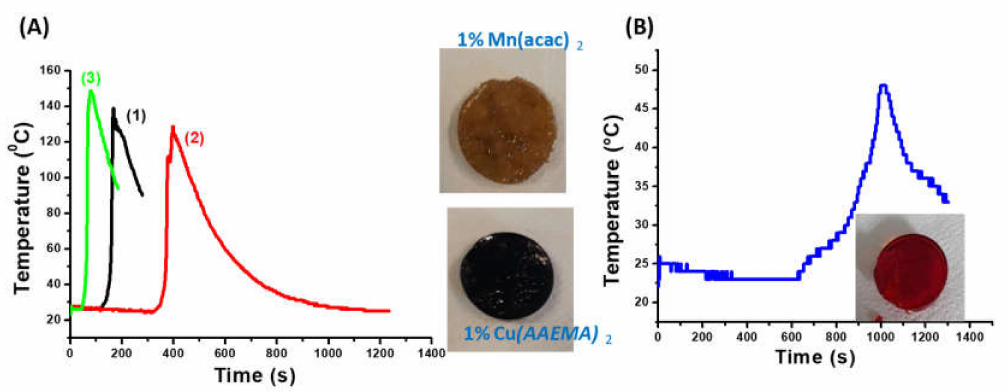
Figure 2. Optical pyrometric measurements (temperature vs. time after mixing; 4 mm thick sample) under air in resin 1 for Redox FRP of ( A ): (1) Mn(acac) 2 / diphenylsilane (DPS) (1 / 1 %wt), (2) Cu(AAEMA) 2 / DPS (1 / 1 %wt), (3) Mn(acac) 3 / DPS (1 / 1 %wt) and ( B ) Fe(acac) 3 / DPS (1 / 1.4 wt%) initiating